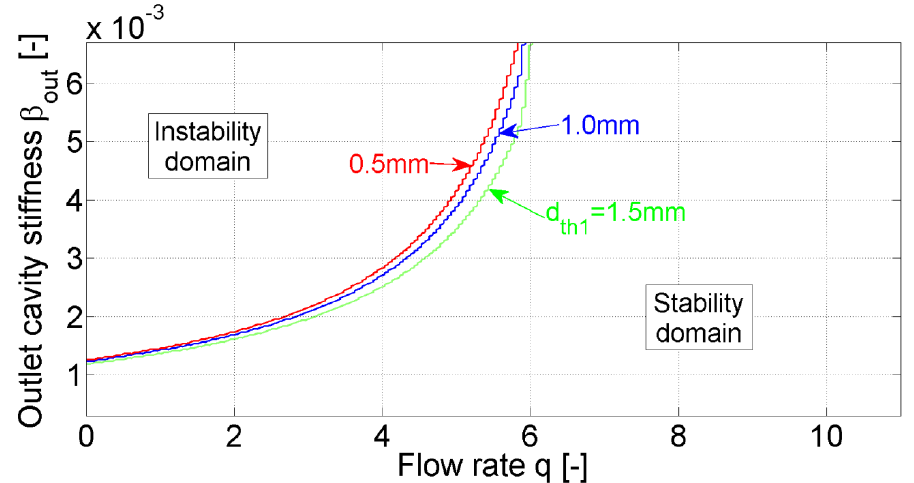
Figure 8. Stability domains at various diameter d th 1 of throttle 11 for the constant values of leakage Q leak and area of throttle 10 ( A th 2 = 1.77 mm 2 , Q leak = 16 l / min ).